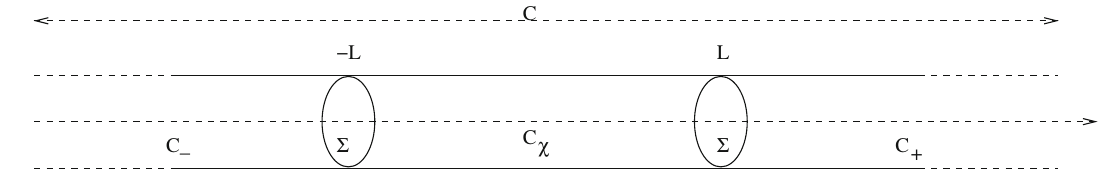
Fig. 1 The geometry for the problem at hand is displayed. The region C χ contains the dielectric medium, the other two cylindrical regions C ± with the same radius R are void. The inner boundaries indicated